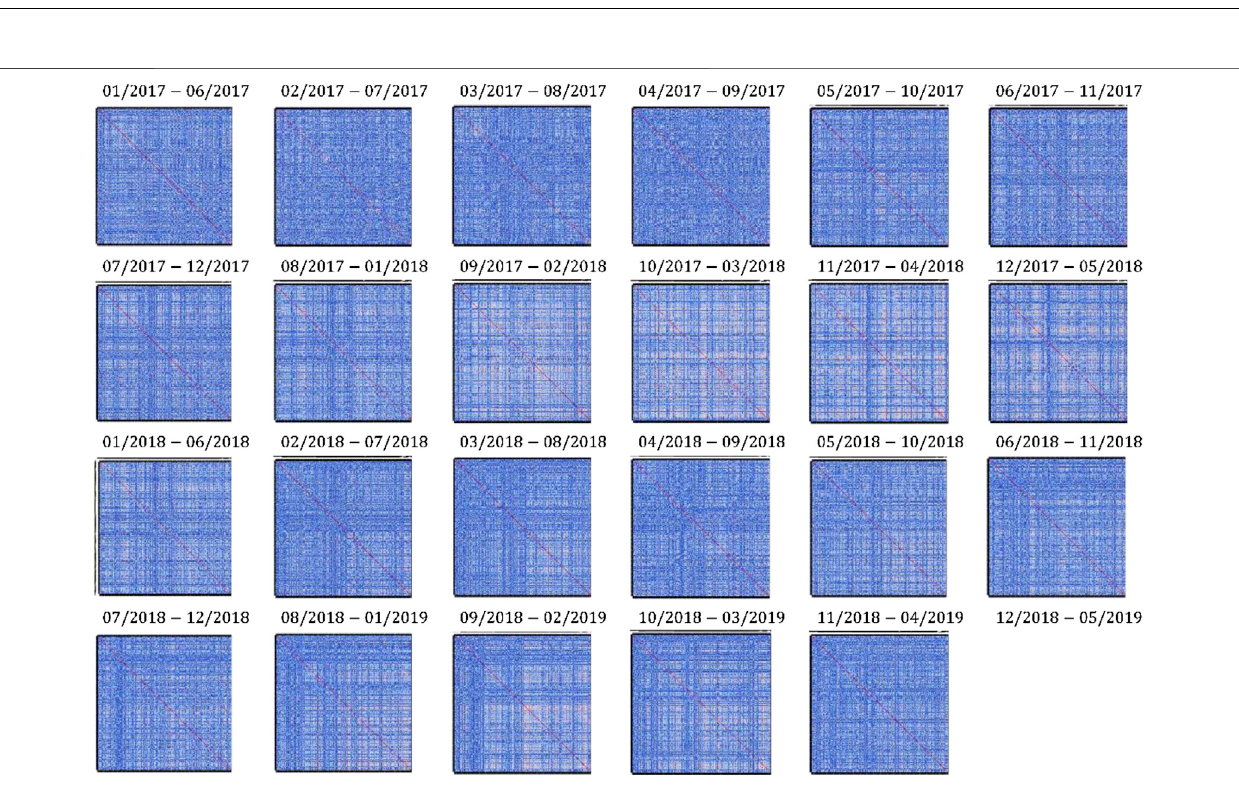
FIGURE 7 | A schematic diagram illustrating different states in the stock market across a market crash. (A) All stock components are interconnected and form a singlegiantclusterwithholes. (B) Asthemarketstartstocrash,someoftheconnectionsarebroken,butthesinglegiantclusterremainsasincase (A) . (C) Asthemarket crashprogresses,thegiant clusterremains, but partofithas fragmented intofoursmallerclusters. (D) Attheendofthemarket crash, thestocksarenow organized into many small and disjoint clusters.